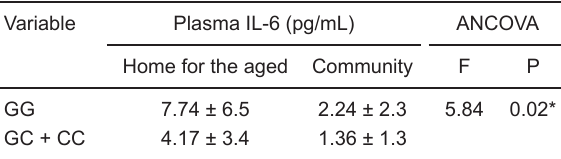
Table 3. Comparison of IL-6 levels between groups of genotypes GG vs GC + CC for IL6 gene -174 G/C